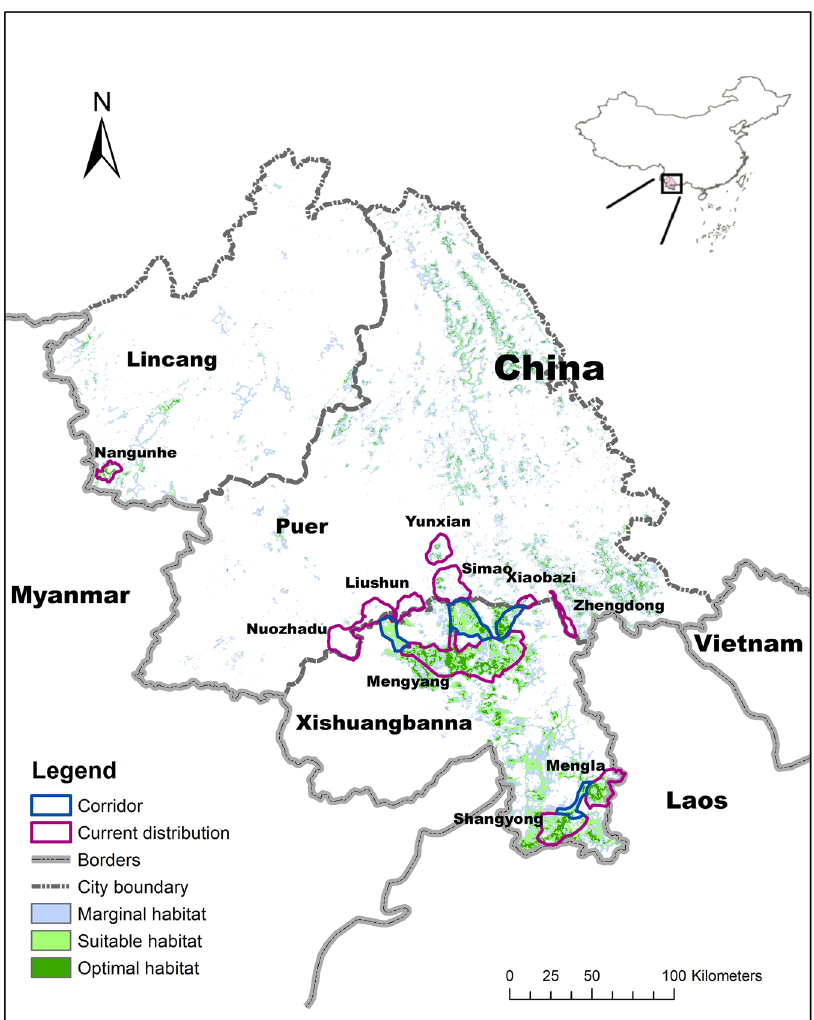
Figure 6. The expected design for Asian elephant corridors in China (Zhang et al . 8 ). Software: ArcGIS 10 . 2 ( ESRI Ltd ., CA , USA .